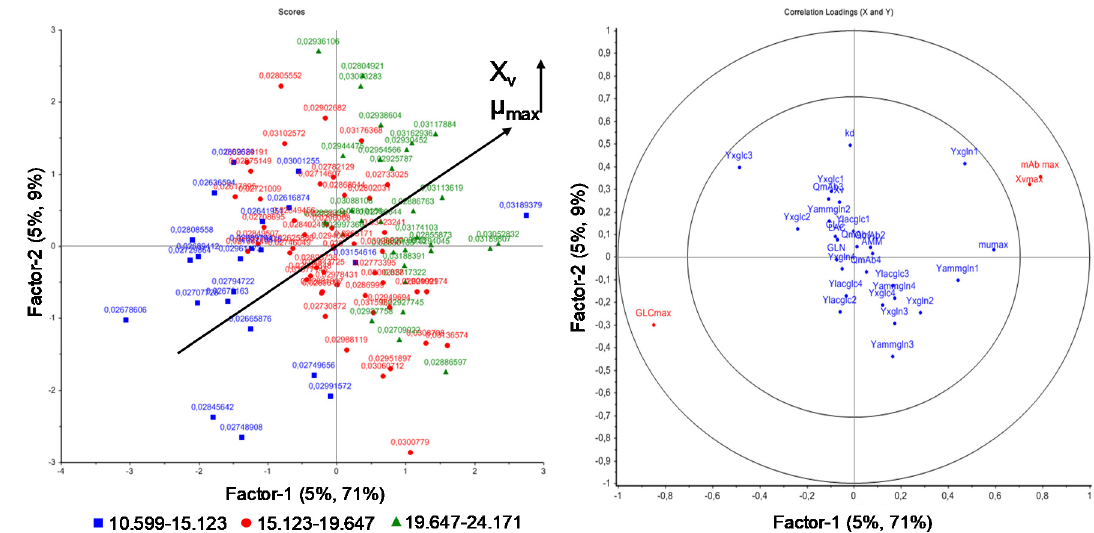
Figure 8. PLS regression loadings (right) for the maximum viable cell concentration X V,max , maximum glucose concentration (GLC max ), and maximum antibody concentration (mAb max ) as response, depending on model parameters (predictors) as well as PLS regression scores (left) grouped into the correlation between maximum growth rate µ max and X V .